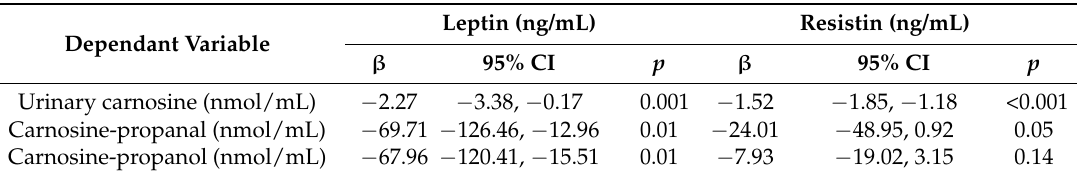
Table 2. Multivariable quantile regression analyses for relationships between change in serum adipokines and change in urinary carnosine levels. Leptin (ng/mL) Resistin (ng/mL) Dependant Variable β 95% CI p β 95% CI p Urinary carnosine (nmol/mL) − 2.27 − 3.38, − 0.17 0.001 − 1.52 − 1.85, − 1.18 <0.001 Carnosine-propanal (nmol/mL) − 69.71 − 126.46, − 12.96 − 48.95, 0.92 Carnosine-propanol (nmol/mL) − 67.96 − 120.41, −